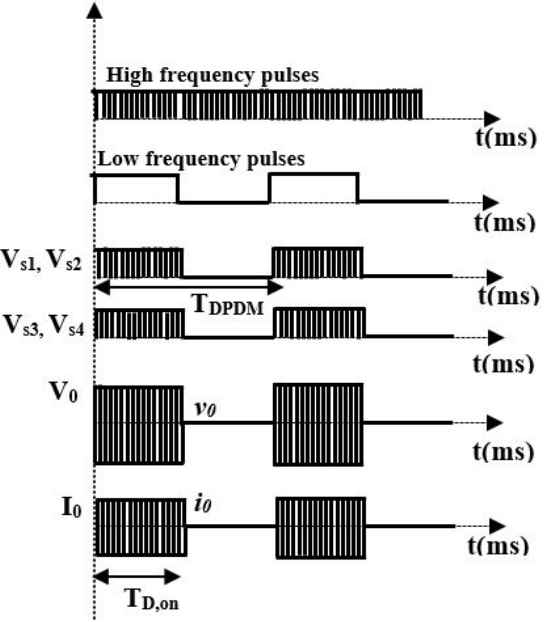
Figure 5. Typical waveforms of pulse density modulation